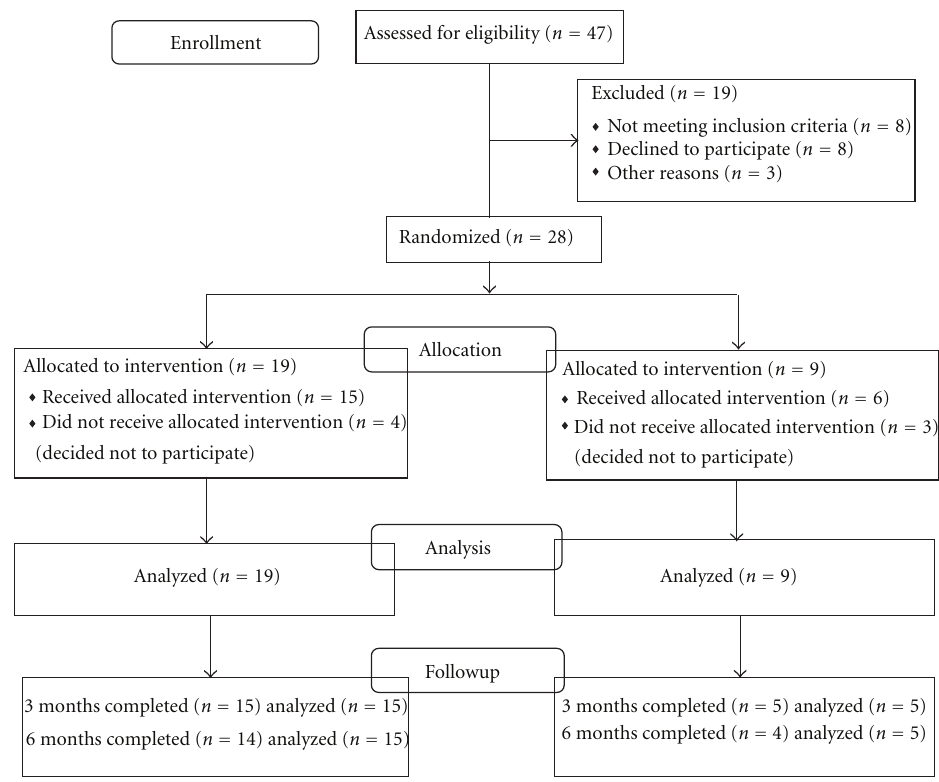
Figure 1: Subject flow